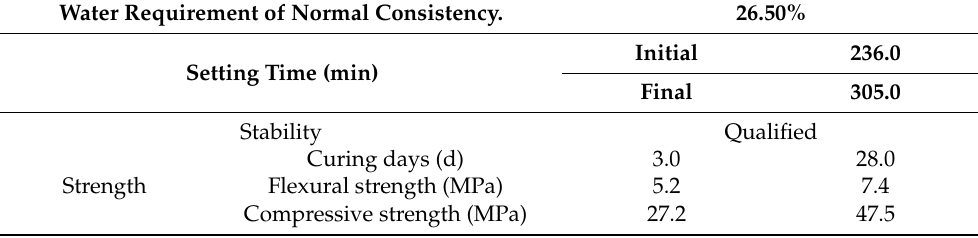
Table 1. Physical properties of cement.